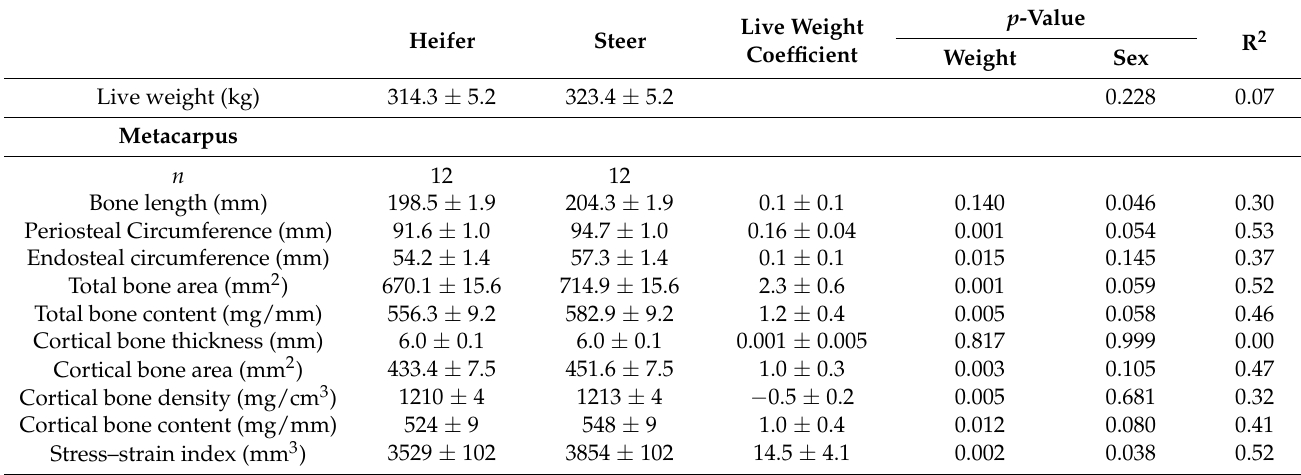
Table 2. Least square means and standard error of bone parameters adjusted for live weight of heifers and steers at 11 months of age from cohort two where there was no interaction of weight and